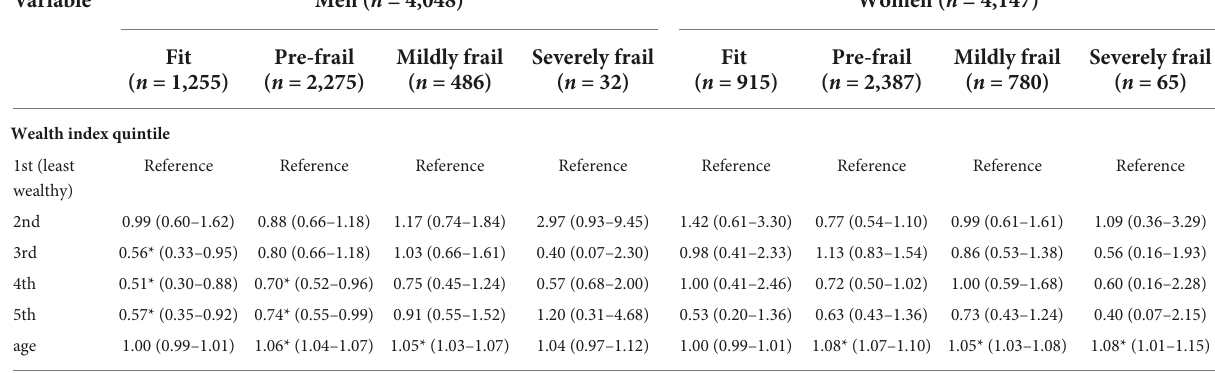
TABLE 5 The associations between 7 year all-cause mortality and wealthy status and age among Thai older adults with different frailty status stratified by gender.